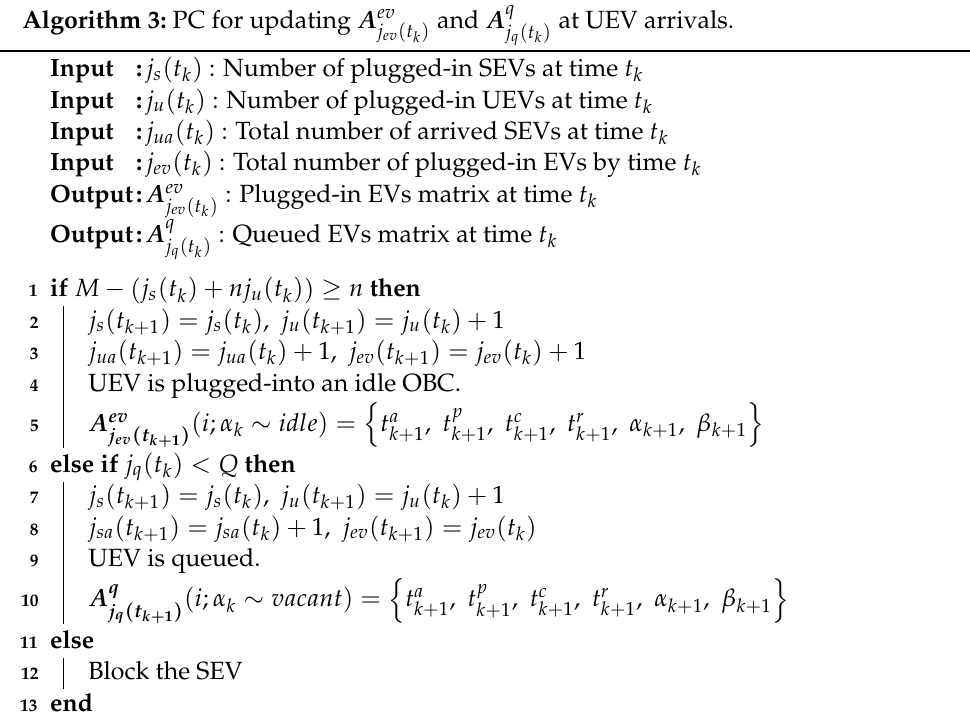
at UEV and A q j ev ( t k ) j q ( t k )